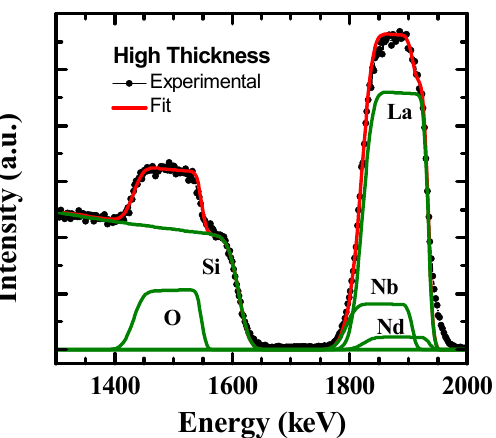
Figure 3. Compositional fitting of the pre-annealed HT thin film carried out by Rutherford backscat- tering spectroscopy.